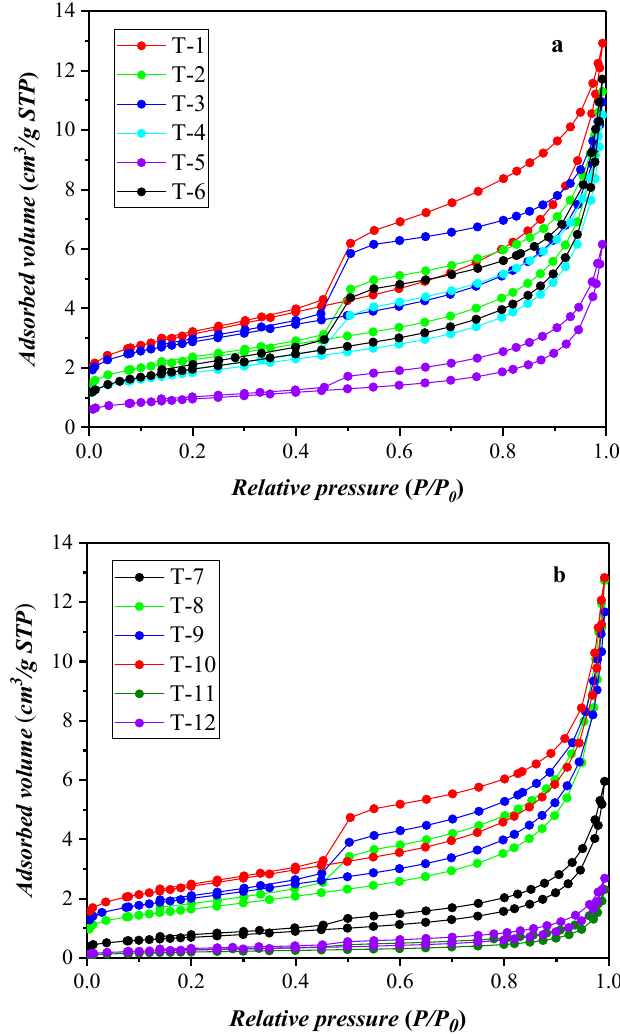
Figure 3. Nitrogen adsorption/desorption isotherms at − 196 °C for the 12 shale samples: (a) The first six shale samples, (b) The last six shale samples.